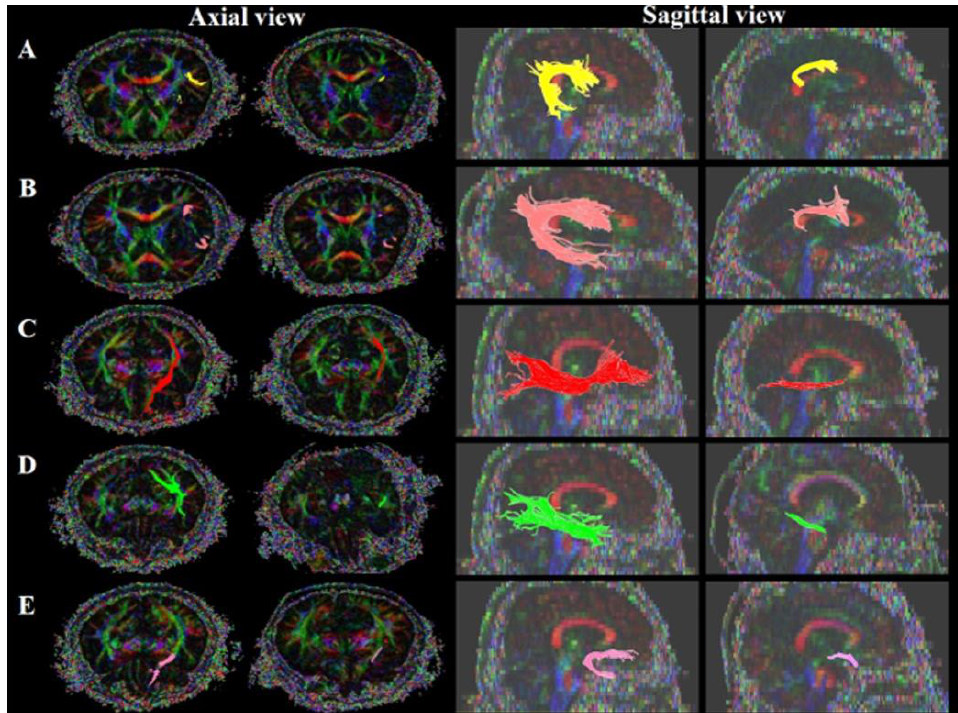
Figure 1. Language-related white matter: ( A ) AF, arcuate fasciculus; ( B ) SLF, superior longitudinal fasciculus ( C ) IFOF, inferior fronto-occipital fasciculus; ( D ) ILF, inferior longitudinal fasciculus; ( E ) UF, uncinate fasciculus.